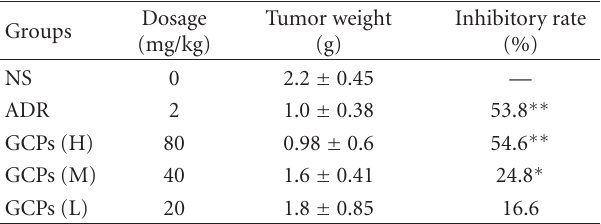
Table 2: Inhibitory e ff ects of Gecko on transplanted H22 mice (mean ± SD, n = 10).